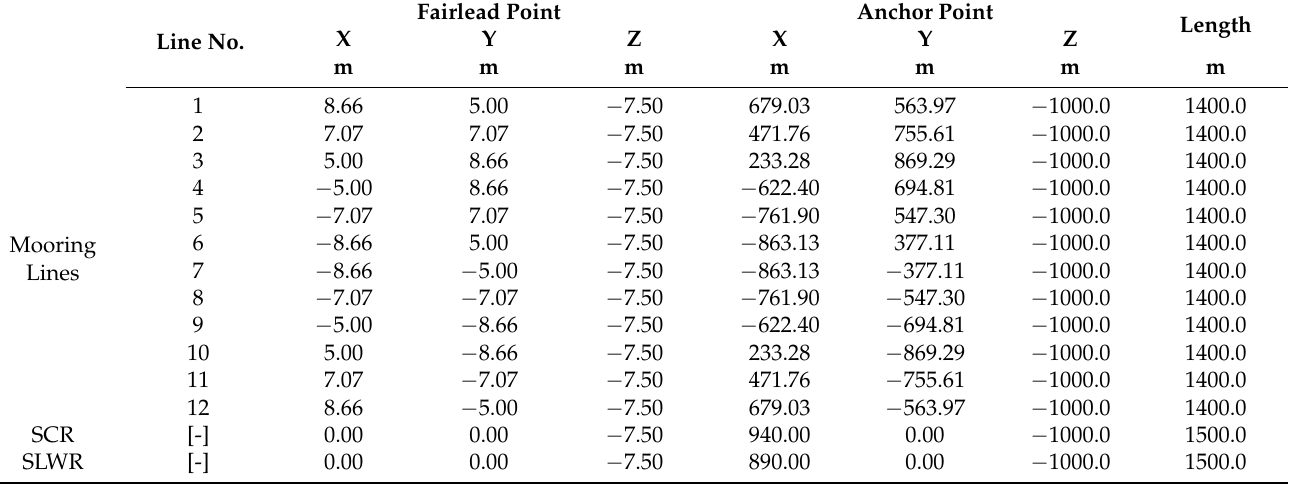
Figure 9. Mooring and Riser (SCR) Arrangement.